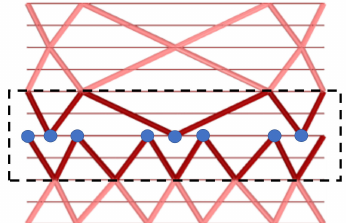
Figure 5. Example of unfeasible